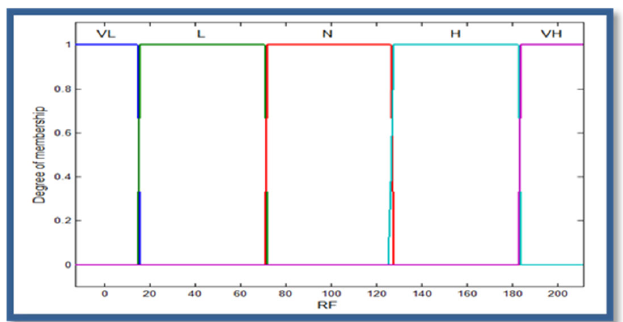
Fig. 10. Membership functions related to humidity (HU) – middle model